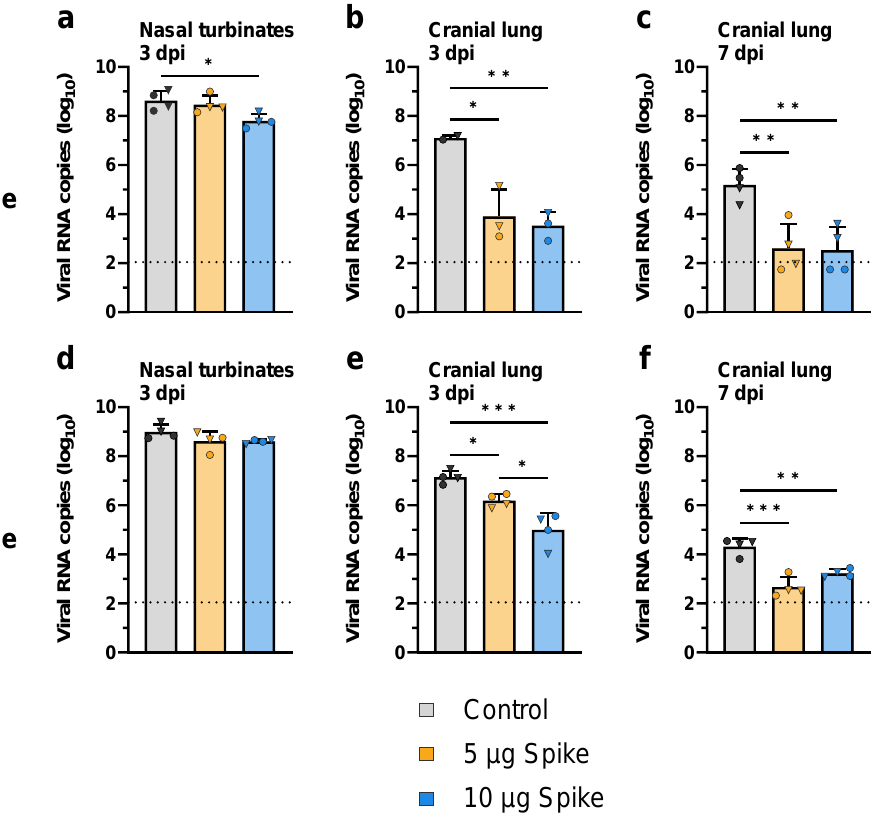
Figure 6. Viral RNA in the upper and lower respiratory tract after challenge with SARS-CoV-2. Viral RNA was quantified by RT-qPCR of RNA extracted from tissue samples collected from hamsters challenged with the ( a – c ) Beta or ( d – f ) Delta variant of SARS-CoV-2. Sampled tissues include ( a , d ) nasal turbinates collected 3 days post challenge, as well as cranial lung samples collected on ( b , e ) day 3 and ( c , f ) day 7 post challenge. Values indicate viral RNA copies per 100 ng of extracted RNA. Values for individual animals are presented as either circles ( ● ) for females or triangles ( ▼ ) for males. Dotted line indicates lower limit of detection. Data are mean + SD. Results were analyzed by one-way ANOVA with Tukey’s multiple comparisons test, with p < 0.05 considered significant. * p < 0.05, ** p < 0.01, *** p <